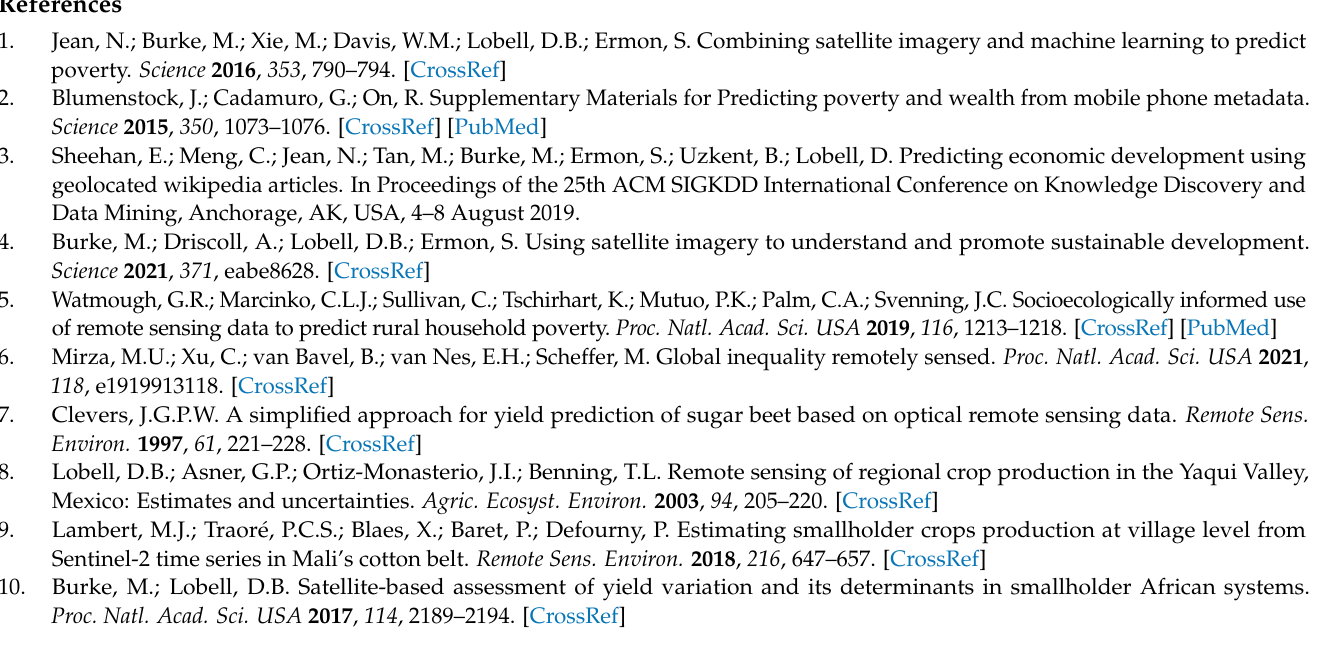
by crop, Table S1: Crop-cut correlations by study, Table S2: Self-report correlations with crop-cut, Table S3: Uganda correlations for adjacent and random crop-cut